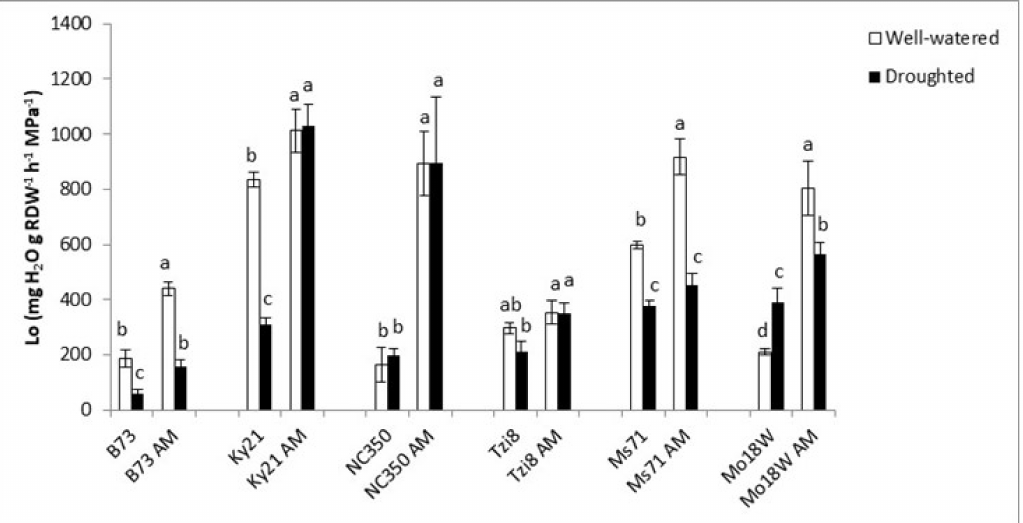
Figure 8. Osmotic root hydraulic conductivity (Lo) in six maize NAM lines (B73, Ky21, NC350, Tzi8, Ms71 and Mo18W) inoculated or not with an arbuscular mycorrhizal (AM) fungus. Plants were cultivated under well-watered conditions or subjected to drought stress. Data represents the means of 6 values ± S.E. Within each maize line, different letters indicate significant differences between treatments ( p < 0.05) based on Duncan’s test.